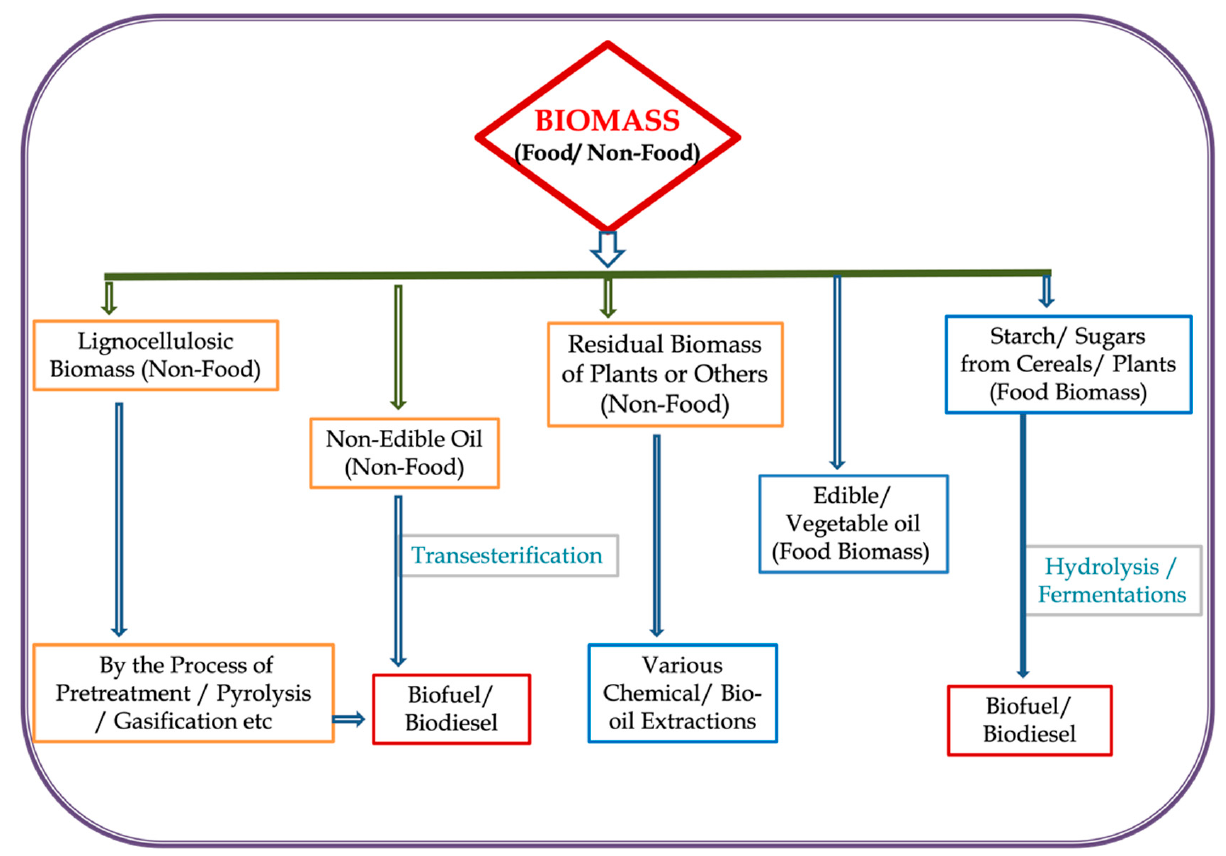
Figure 3. Schematic representations of second-generation biofuel (adopted and modified from Naik et al. [13].)